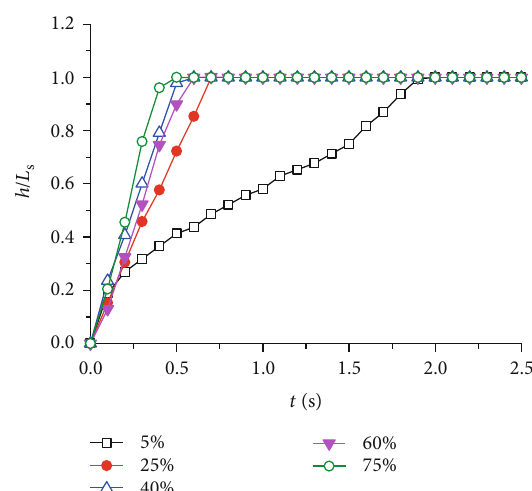
Figure 11: Climbing height of di ff erent volume fractions